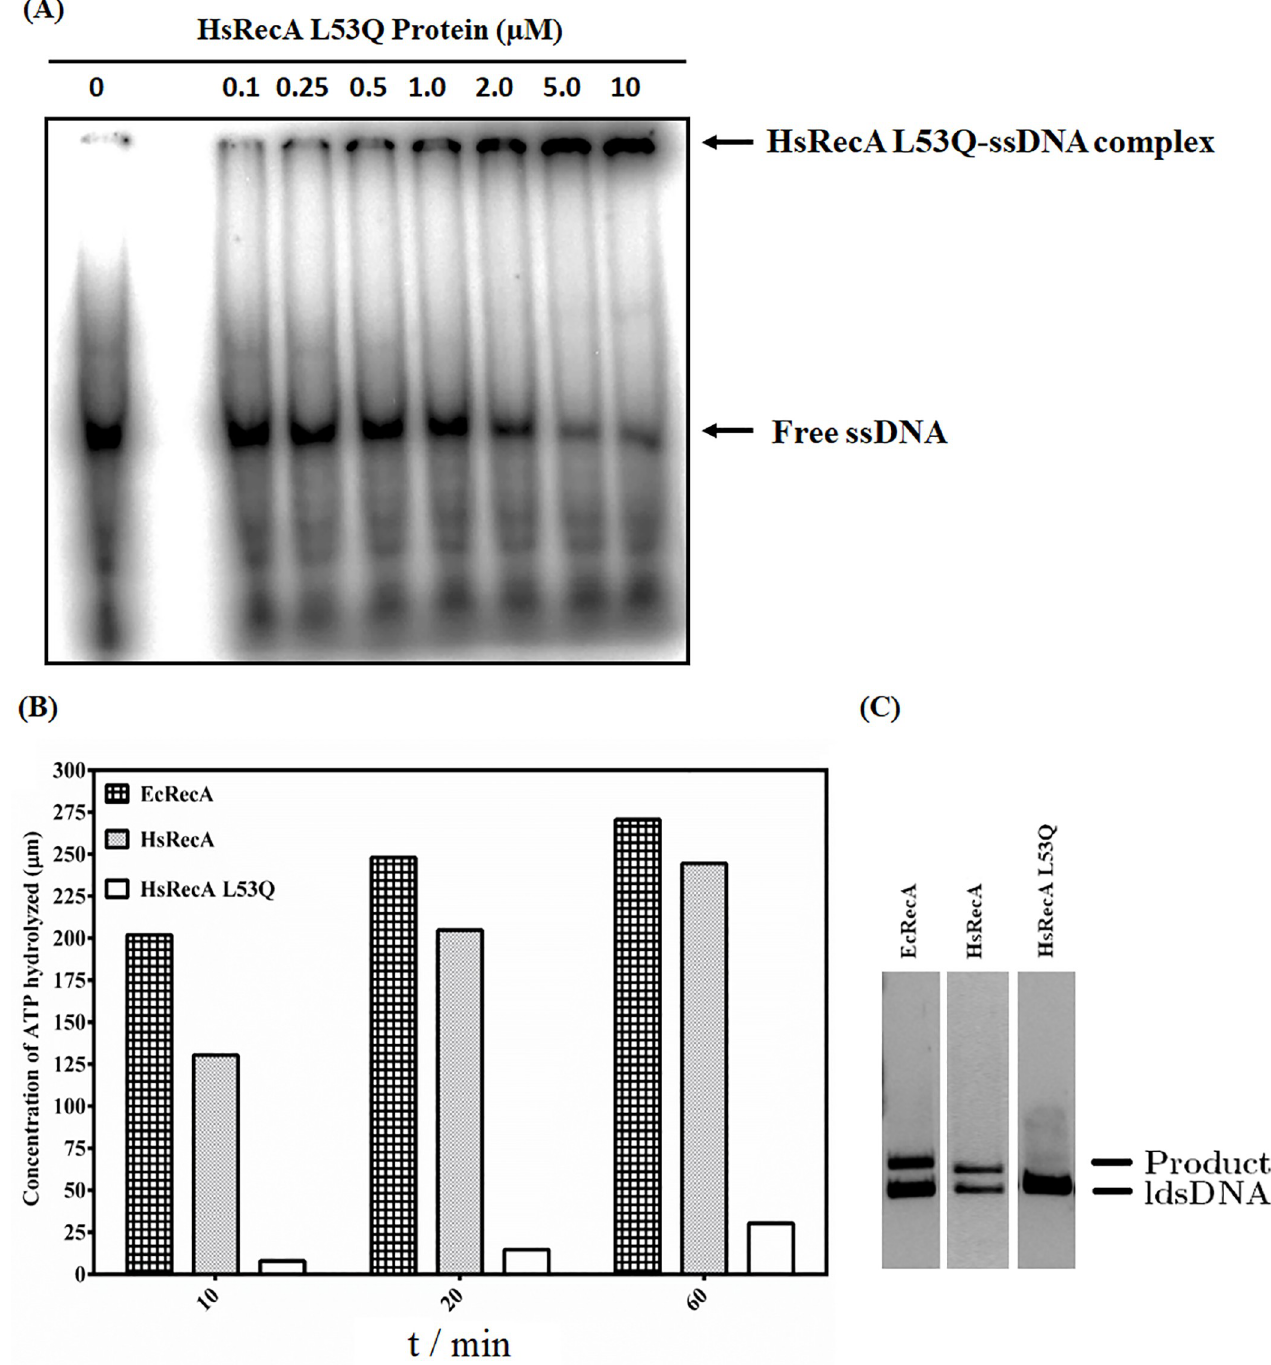
Fig 2. ssDNA-binding of HsRecA L53Q, ATPase and DNA strand exchange activity promoted by EcRecA, wild-type HsRecA and HsRecA L53Q proteins. (A) ssDNA-binding capacity of HsRecA L53Q assayed by using [ α 32 P]-ssDNA 88 mers . (B) Amounts of ATP hydrolyzed. The ATPase activity profile of wild-type HsRecA was previously characterized [15,24].(C) The three DNA strand exchange activity. These results are representative of three separate experiments.